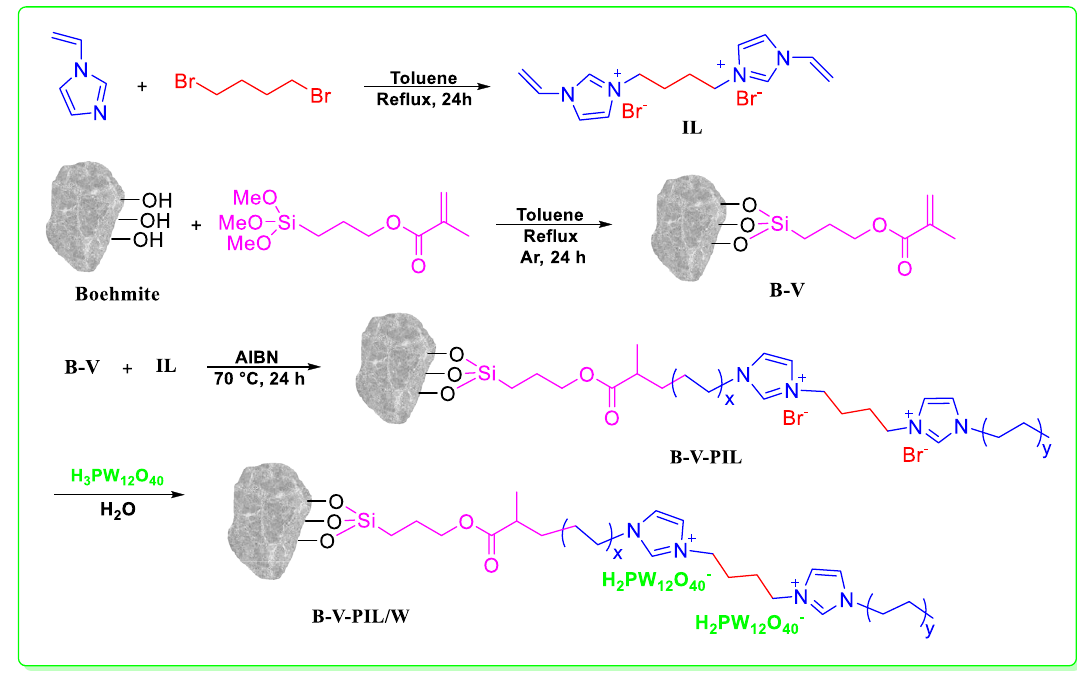
Figure 1. Pictorial synthetic route for the preparation of